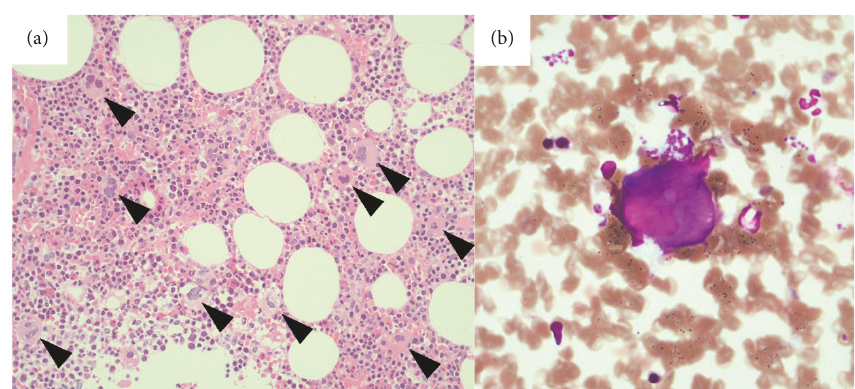
Figure 3: The histological findings of bone marrow biopsy and aspiration. (a) The bone marrow was normocellular with increased megakaryocytes (arrow heads) (magnification: × 200; hematoxylin and eosin staining). (b) Few platelets were visualized around and near the megakaryocytes (magnification: × 400; Wright-Giemsa